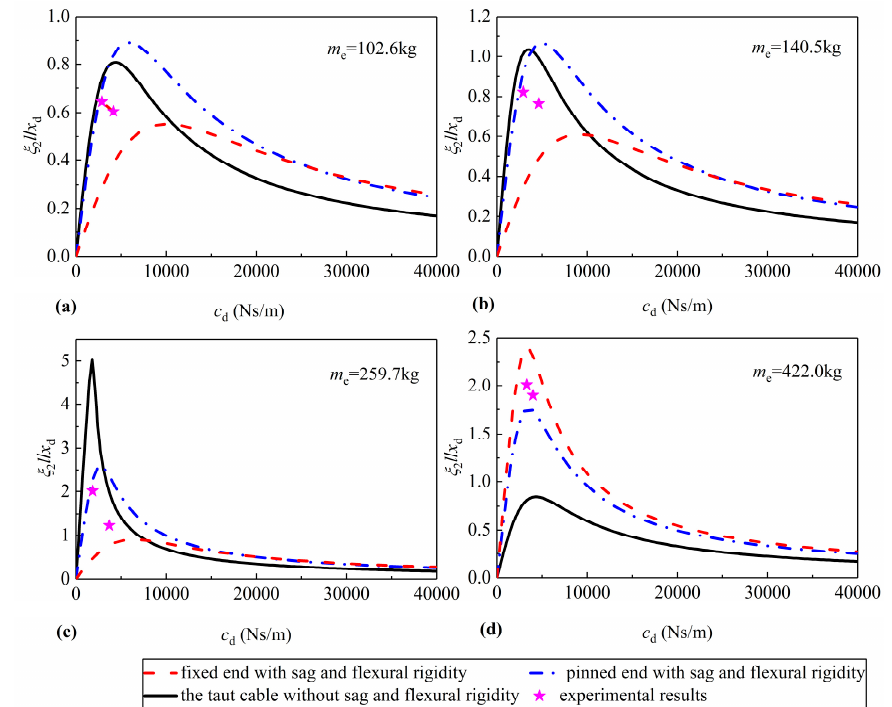
Figure 3. Comparison between the theoretical and experimental supplemental modal damping ratios in the second mode of the cable: ( a ) m e = 102.6 kg; ( b ) m e = 140.5 kg; ( c ) m e = 259.7 kg ( d ) m e = 422.0